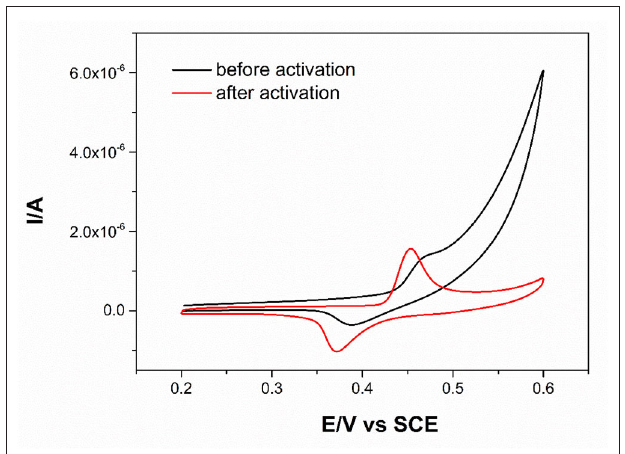
FIGURE 3 | CV curves of Ni-MOFs before and after treatment in 0.1M KOH, scan rate 50mV s − 1 .